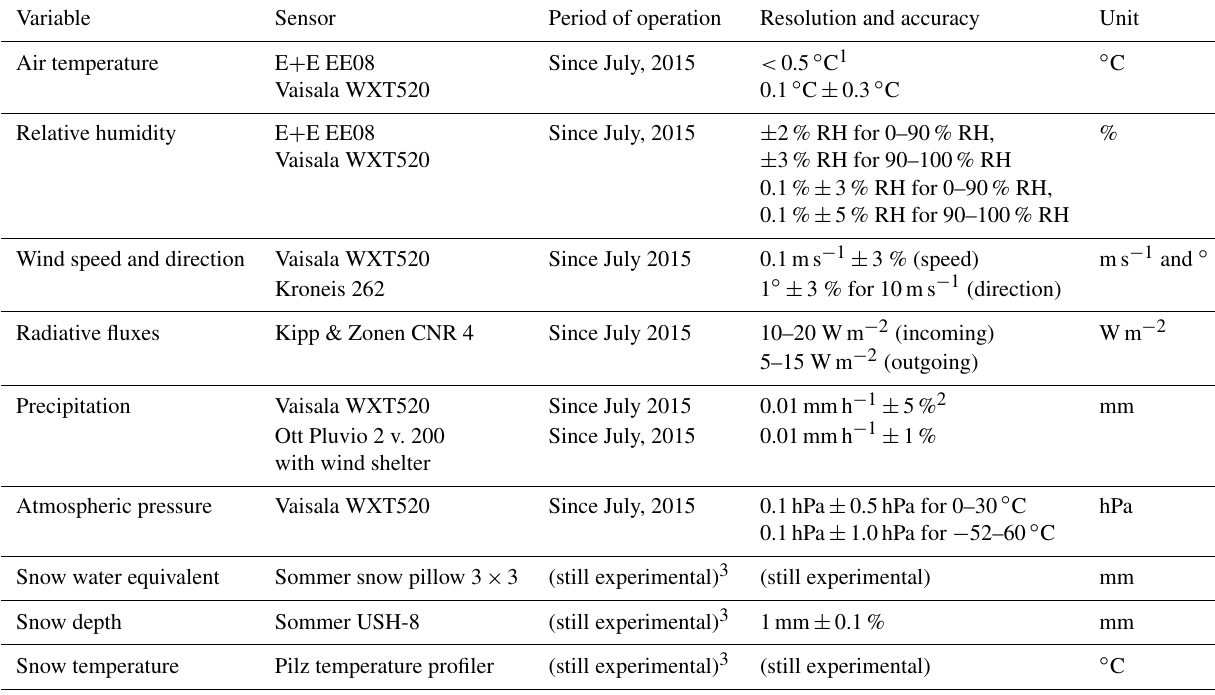
Table 6. Weather and snow variables recorded by the sensors installed at the station Bella Vista (2805ma.s.l., 46.78284 ◦ N, 10.79138 ◦ E). Accuracy according to technical data sheets of the manufacturers. Original temporal resolution of the data records is